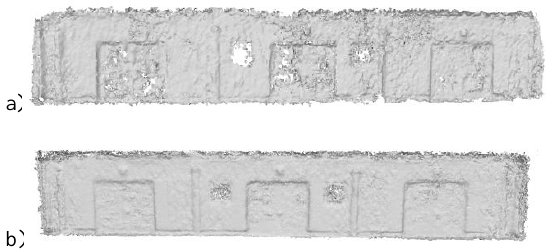
Figure 3. Test object point cloud generated from video frames a) with the 60% coverage, b) with the 85% coverage When comparing these two point clouds it is evident, that the point cloud generated using the 85% overlap video frames is of much higher quality in comparison to the 60% overlap data. In contrast to the cloud generated from 9 video frames, the point cloud of the test object's facade generated using the 80% overlap video frames, is characterized by a much greater smoothness and has fewer geometric deformations. The edges and architectural details are well defined. Only a small amount of noise is visible around the barred windows.